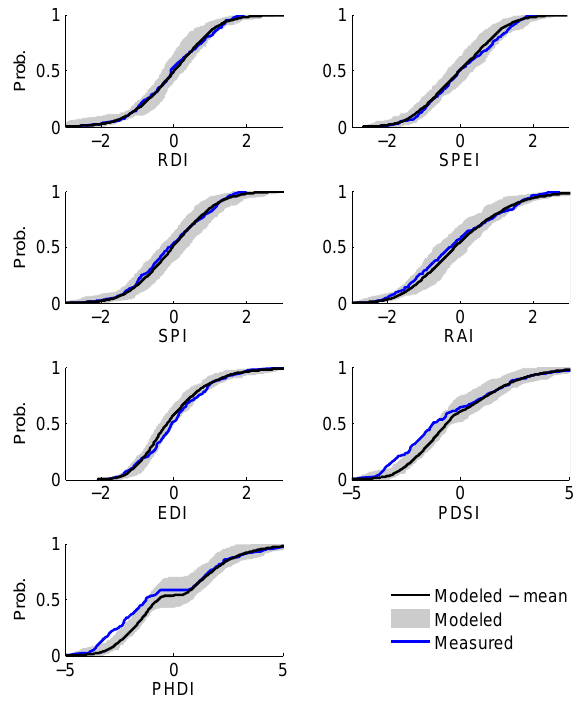
Figure 4. Empirical cumulative distribution functions of daily pre- cipitation for present and future climate scenarios.